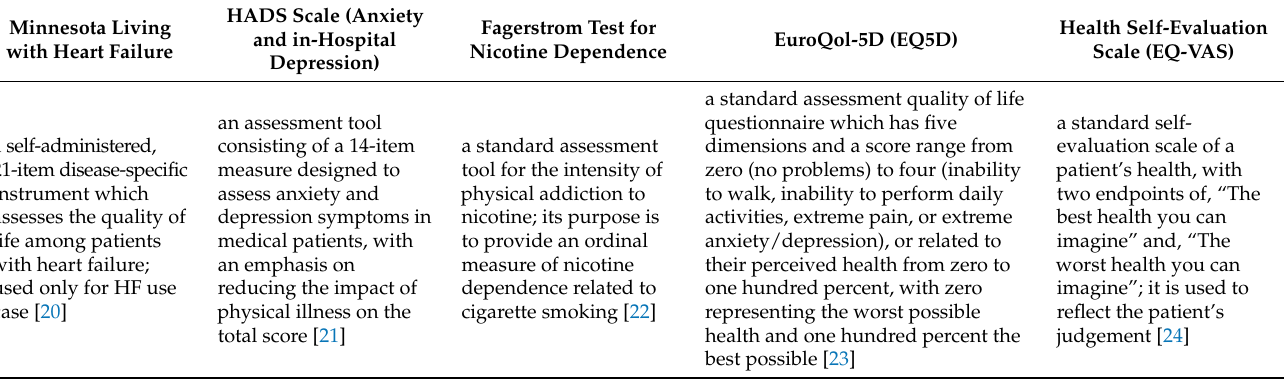
Table 2. Questionnaires used for the psychological evaluation of enrolled patients.